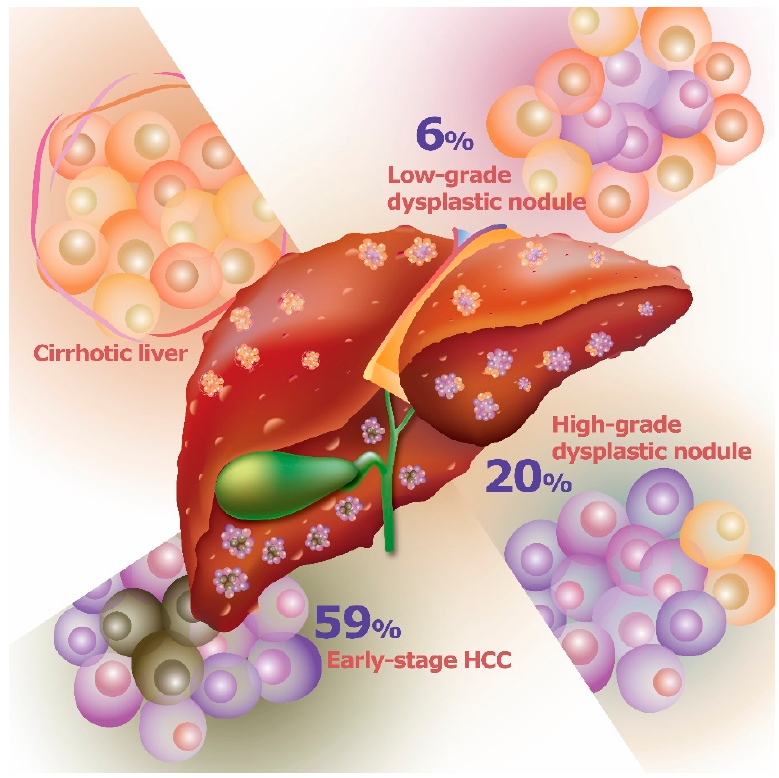
Figure 1. Telomerase reverse transcriptase (TERT) mutation prevalence during HCC progression.